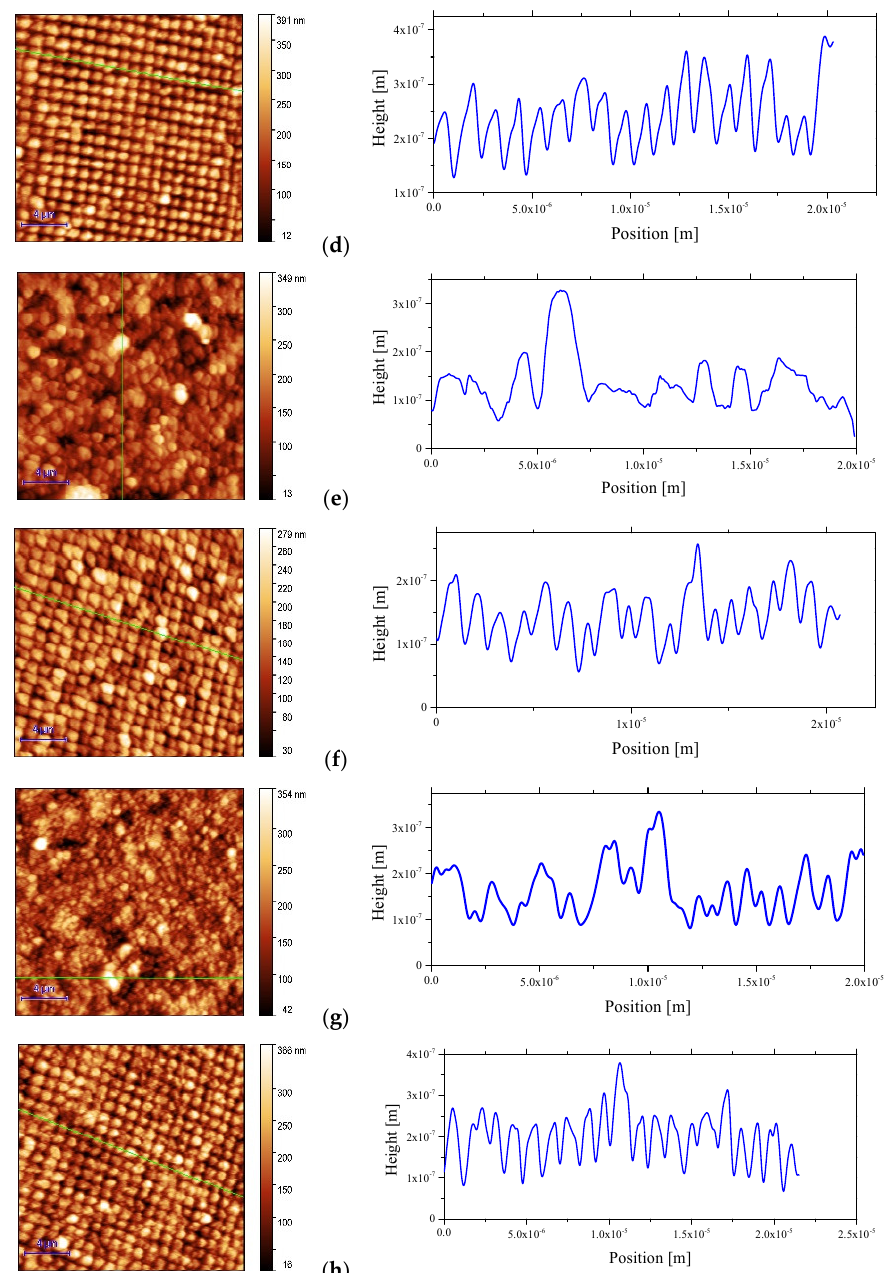
Figure 9. Two-dimensional AFM images and profile line of the prepared samples: Si/Al flat /AMC30:PCBB ( a ); Si/Al nano /AMC30:PCBB ( b ); Si/Al flat /AMC30:AMC14 ( c ); Si/Al nano /AMC30:AMC14 ( d ); Si/Al flat /AMC31:PCBB ( e ); Si/Al nano /AMC31:PCBB ( f ); Si/Al flat /AMC31:AMC14 ( g ); Si/Al nano /AMC31:AMC14 ( h ). A certain morphological regularity was observed in the samples deposited on Al nano . Most of the mixed layers deposited on Al flat were characterized by large grains/clusters of grains of different dimension morphology (Figure 9), as revealed by the profile line, with the exception of AMC31:PCBB (Figure 9e). These mixed layers showed lower roughness, which is associated with a high reflectance. In the case of the same mixed layers deposited on Al nano , the multiple scattering of the radiation inside the nanostructures developed in the Al layer led to a disruptive superposition and lower reflectance associated with higher roughness (Figure